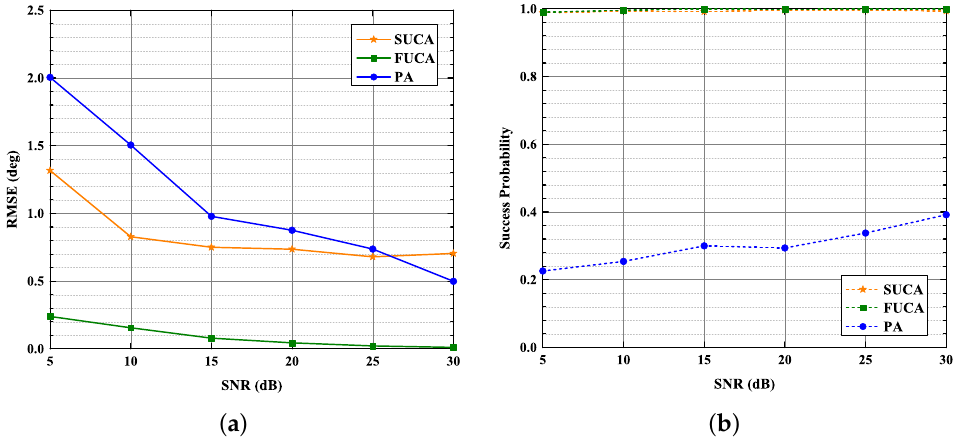
Figure 10. RMSE, Success Probability versus SNR, K = 1024, D = 3: ( a ) RMSE versus SNR; ( b ) Success Probability versus